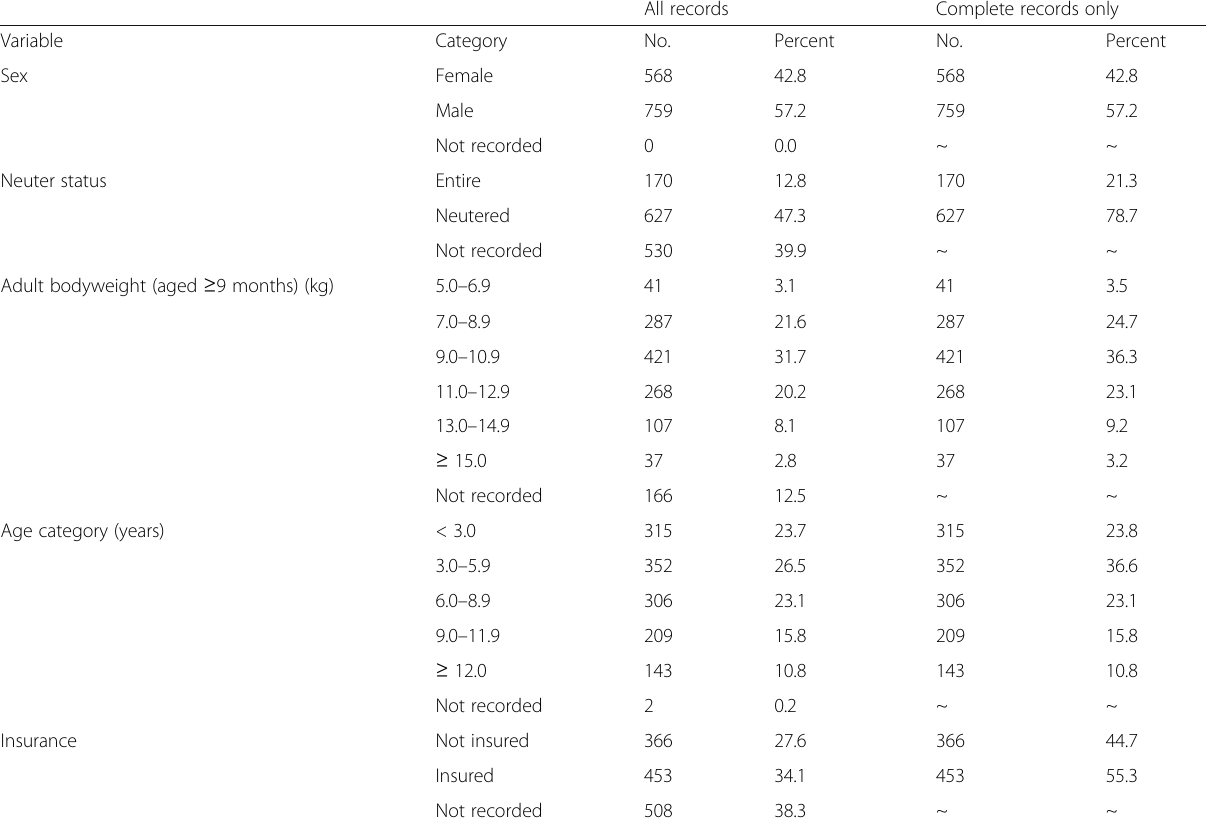
Table 1 Demography of Border Terriers attending primary-care veterinary practices in England from January 1st, 2013 to December 31st, 2013 ( n =